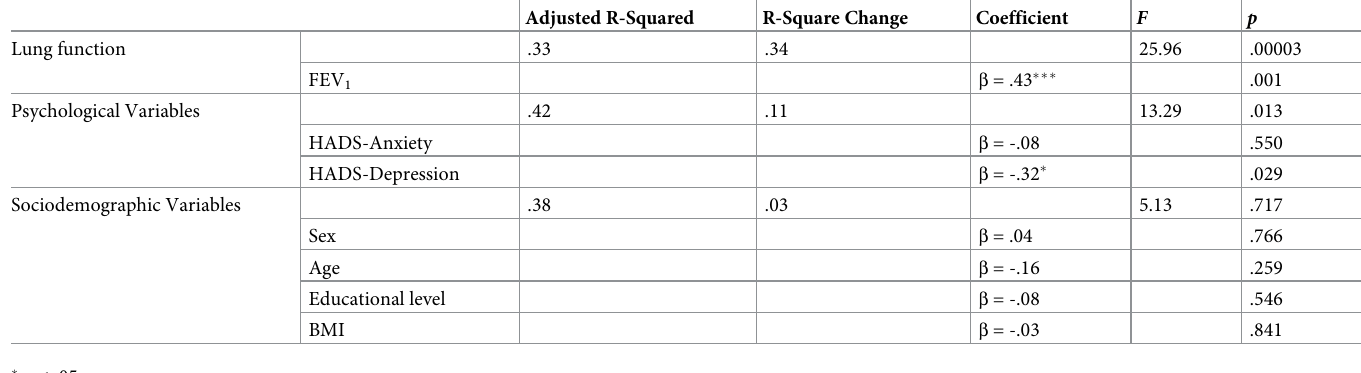
Table 3. Model summary of the hierarchical linear regression analyses with three blocks (lung function, psychological variables and sociodemographic variables) for the 85 hospitalized COPD patients without major